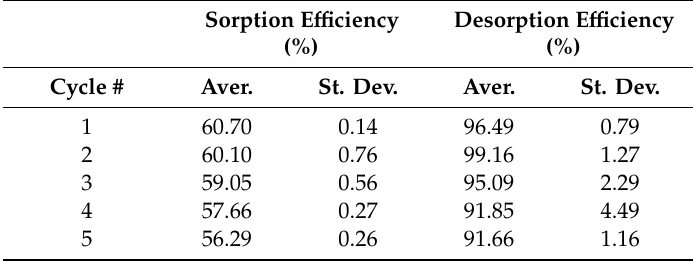
Table 4. Metal desorption and sorbent recycling. Comparison of sorption and desorption performances for five successive